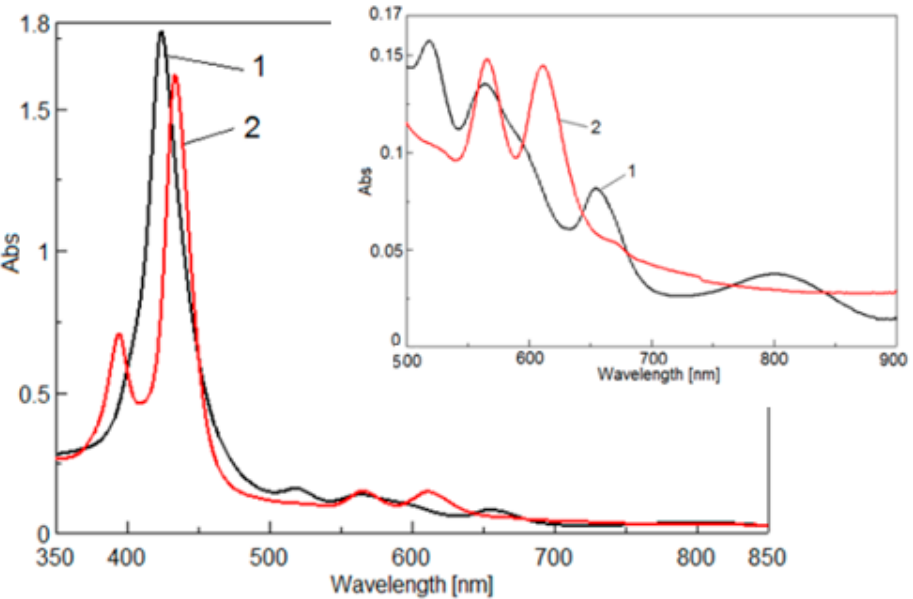
Figure 3. Overlapped UV-VIS spectra of 5,10,15,20-tetrakis-4-aminophenyl-porphyrin ( 1 ) and its Zn-metallated derivative ( 2 ) solved in DMSO; detail of the Q